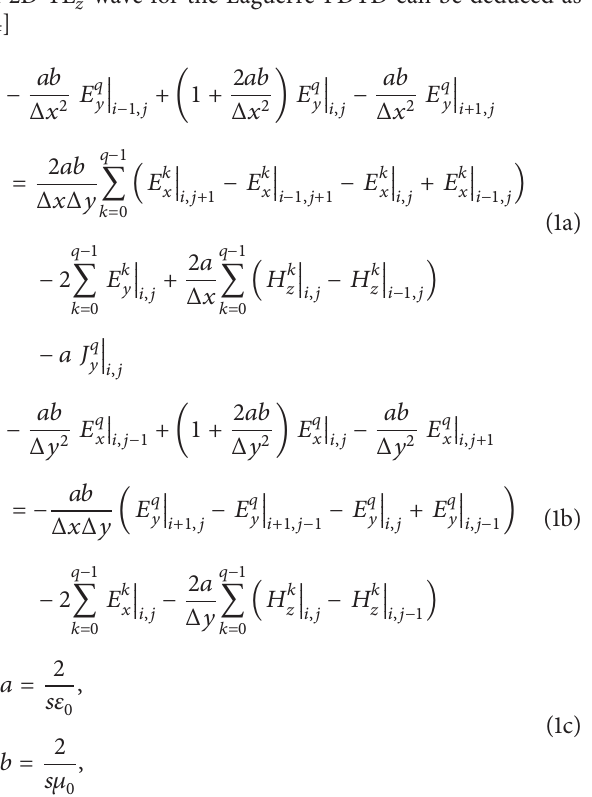
other subdomains and the interface Γ , where Γ = Γ 1 ∪ Γ 2 ∪ ∪ Γ Γ 3 4